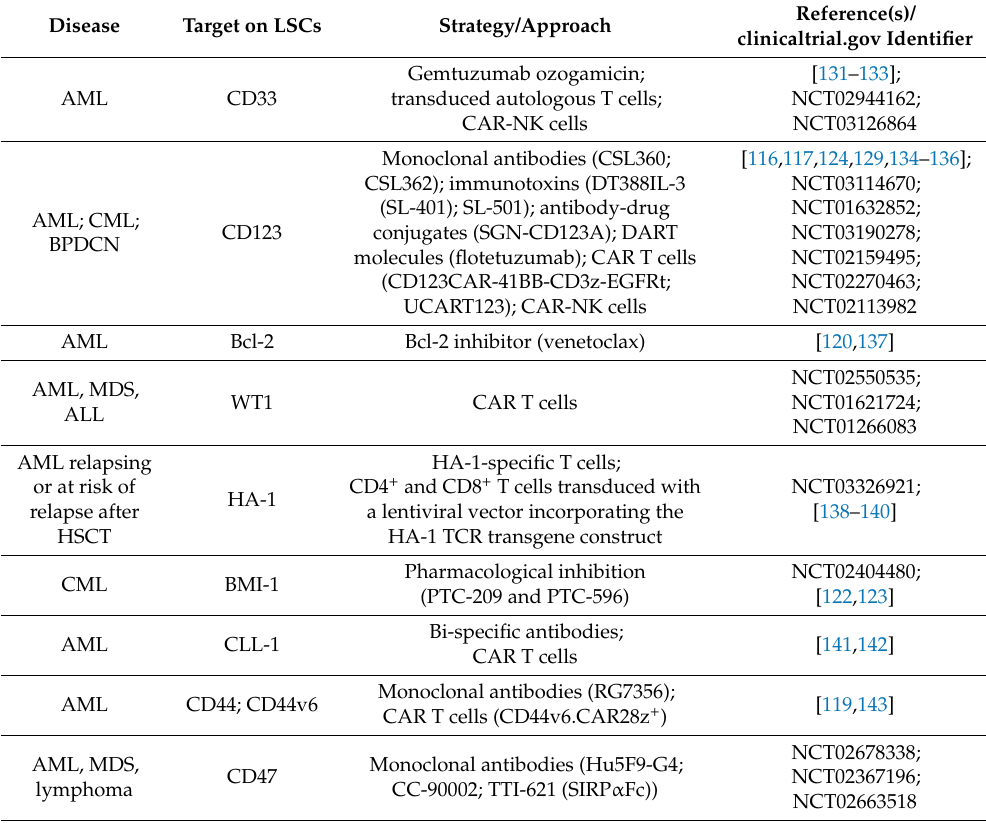
Table 1. Completed and ongoing clinical trials targeting antigens expressed on